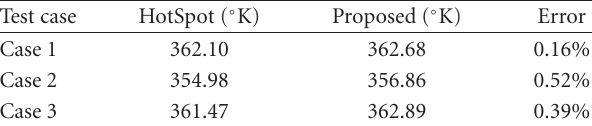
Table 5: Temperature comparison for hard-die